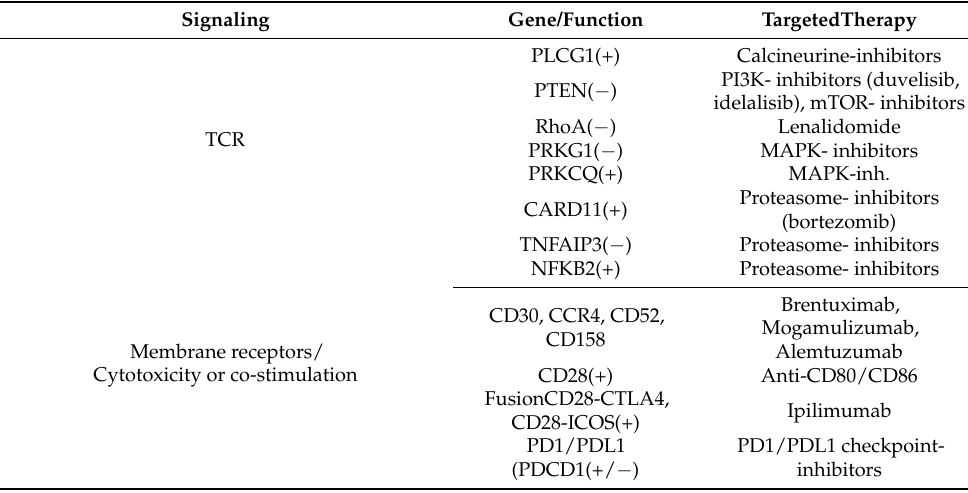
Table 4. Selective/Personalized targeted approaches in